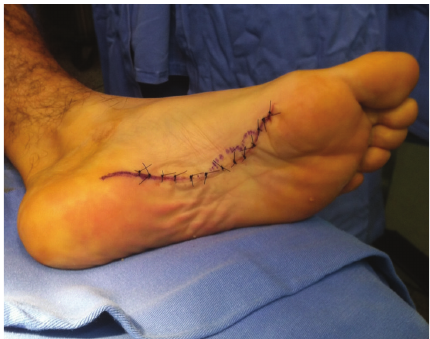
Figure 8: The sutured